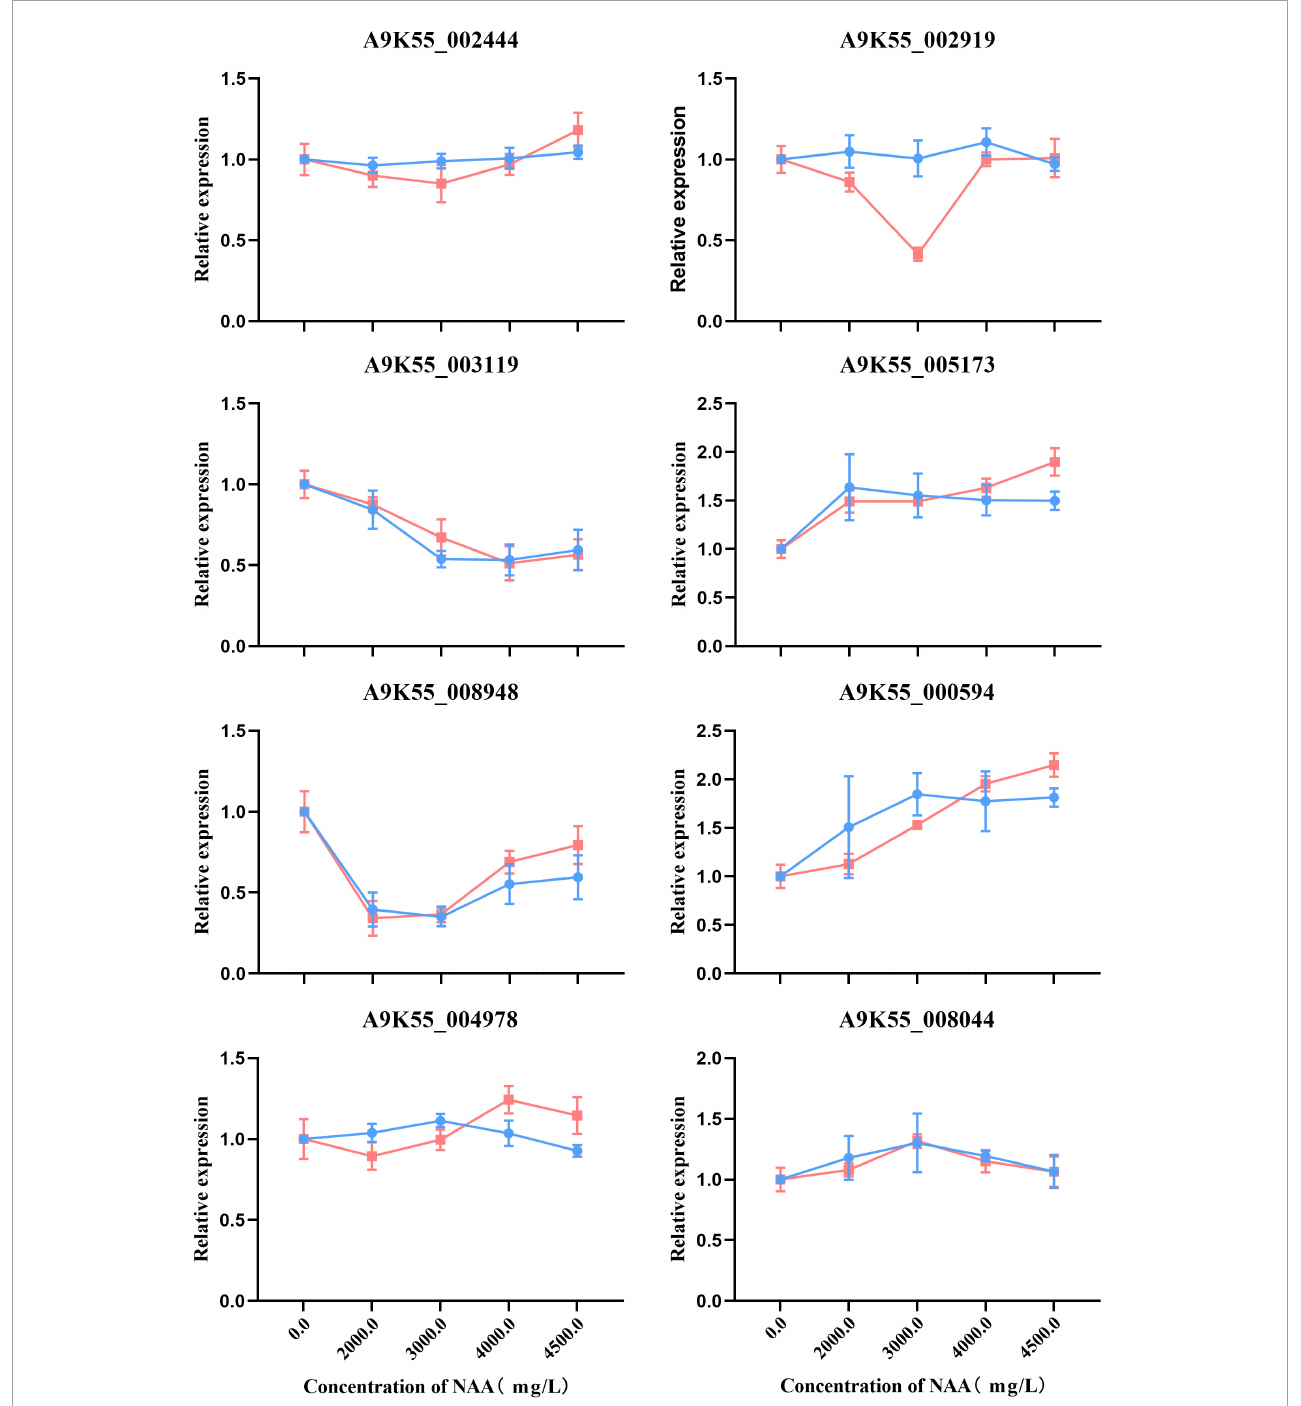
FIGURE8 Real-time quantitative polymerase chain reaction (RT-qPCR) validation of eight genes. Expression patterns of the eight genes involved in purine metabolism, fatty acid metabolism, amino sugar and nucleotide sugar metabolism, glycine, serine, threonine metabolism, and other genes on the metabolic pathway. Each column represents an average of three biological replicates, with standard errors indicated by vertical bars. Values with a different accompanying letter are statistically significantly different according to Duncan’s multiple range test at p <